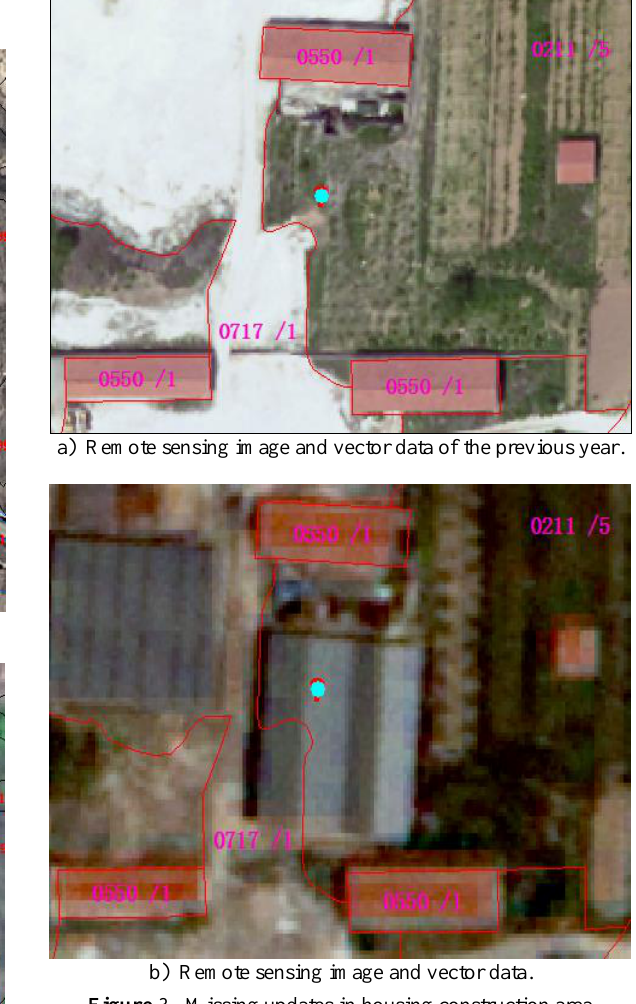
Figure 3. Missing updates in housing construction